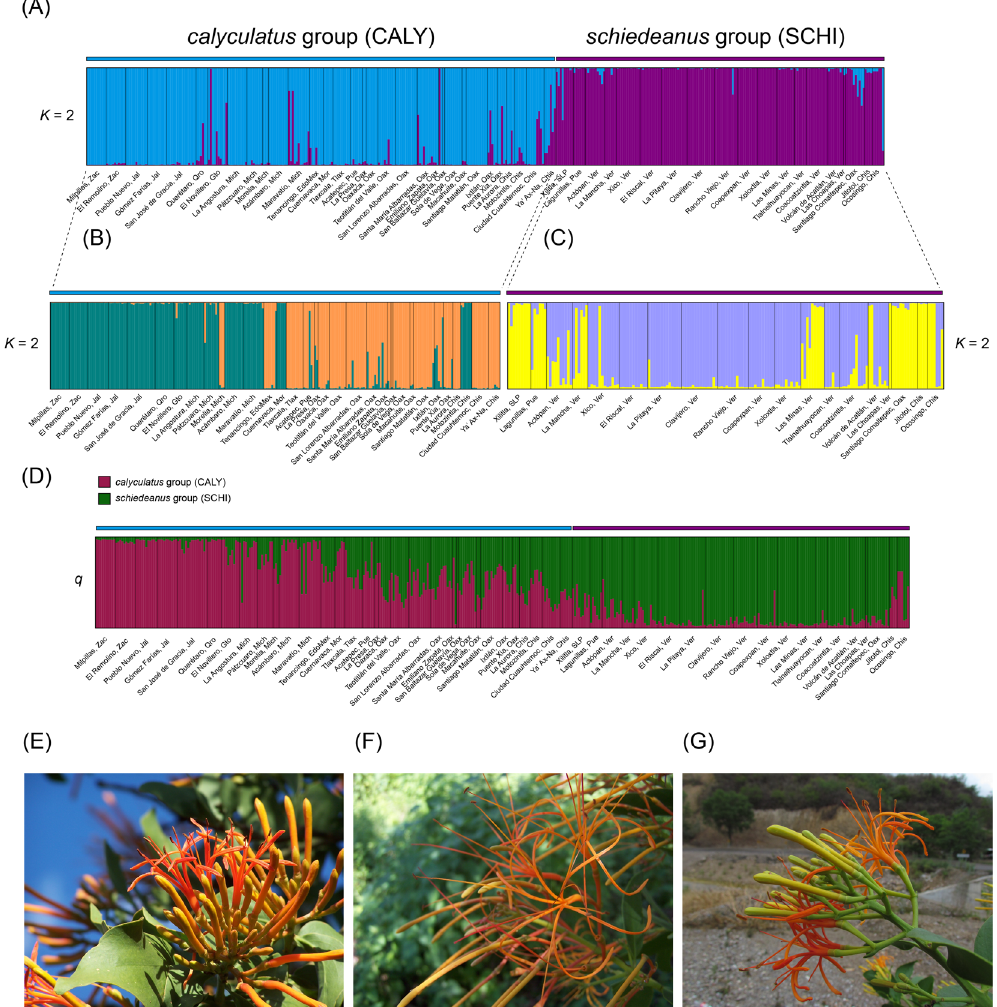
Figure 2. Assignment probabilities ( q ) of 408 P . calyculatus/schiedeanus individuals at K = 2 using STRUCTURE ( A ), and assignment probabilities of individuals to putative sub-structure at K = 2 within each first-level clustering, with individuals of the P . schiedeanus ( B ) and P . calyculatus ( C ) excluded. ( D ) Assignment probabilities of individuals to pure species ( P . calyculatus , P . schiedeanus ) using the POPFLAG prior information and correlated allele frequencies. Each individual is represented by a vertical line that is partitioned into coloured sections, with the length of each section proportional to the estimated membership coefficient. Photos show flowers of ( E ) Psittacanthus calyculatus (by Eduardo Ruiz Sanchez) from Jalisco, ( F ) Psittacanthus schiedeanus (by Juan Francisco Ornelas) from Veracruz, and ( G ) Psittacanthus putative hybrid (by Eduardo Ruiz Sanchez) from the contact zone in Oaxaca. Note their morphological similarities, with P . schiedeanus larger leaves and fruits, and flowers of typically much longer and more slender than flowers of P . calyculatus 21 . Flower size is variable in P . schiedeanus and sometimes appears to be intermediate to P . calyculatus